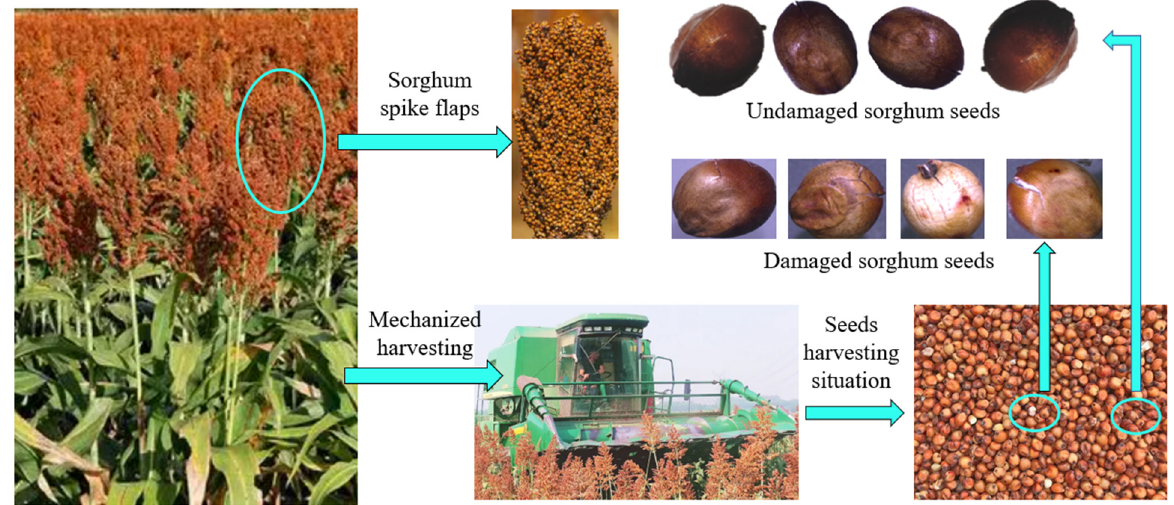
Figure 1. Sorghum seed mechanized harvest and seed breakage.